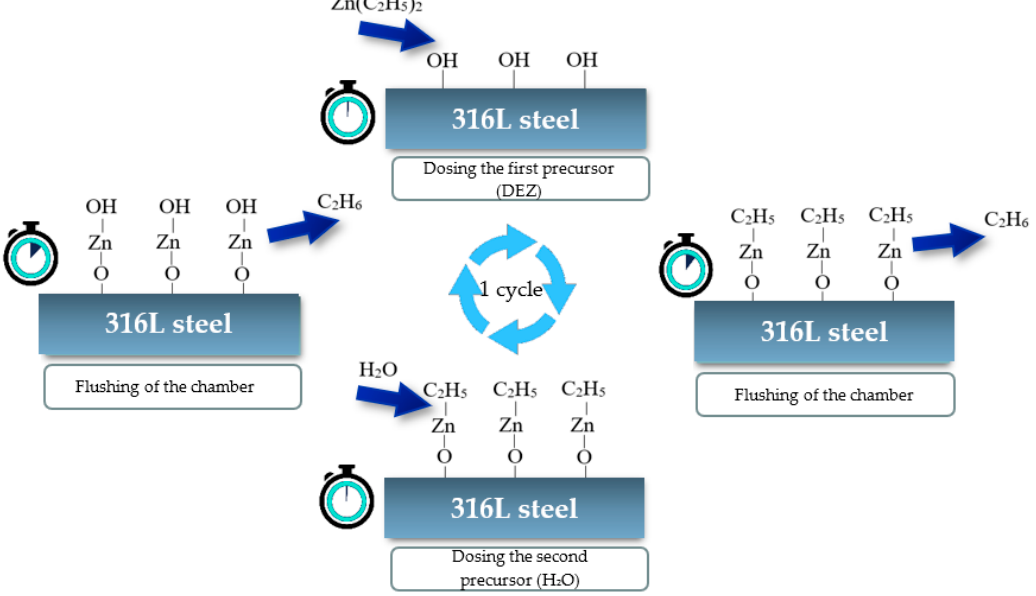
Figure 1. Stages of ZnO layers’ formation in the ALD process.